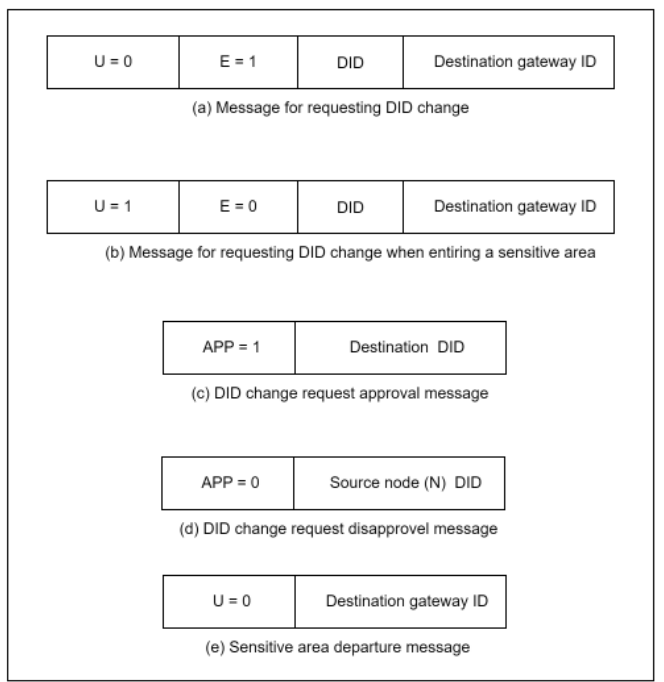
Figure 6. DID change message exchange between nodes and